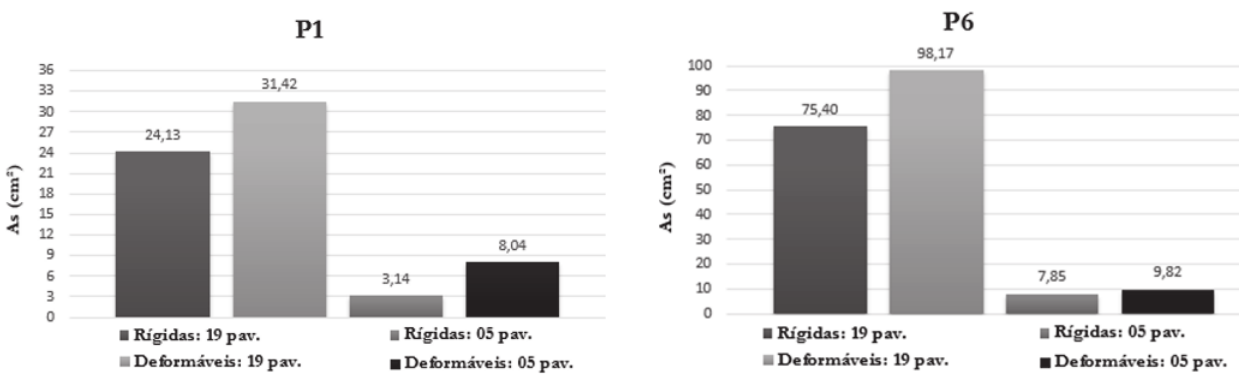
Figura 12 Modelo de Ferreira, El Debs e Elliot [1]: armadura do pilar P1 da estrutura com 19 e